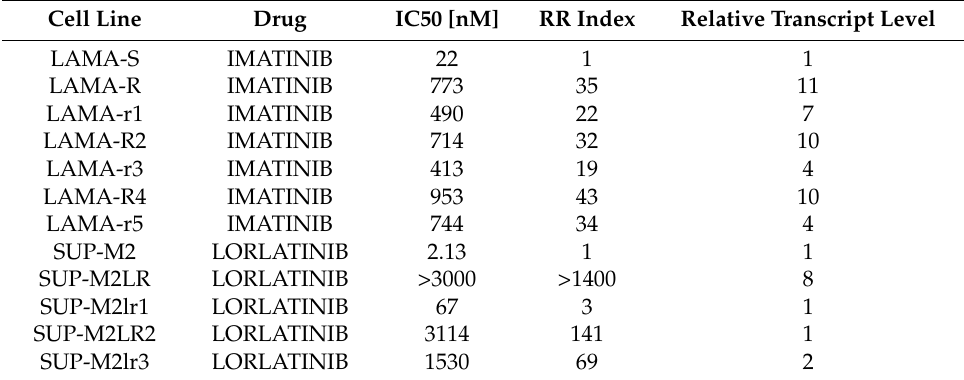
Table 1. IC50 values, Relative Resistance Index, and oncogene transcript level normalized on the parental cells (Relative Transcript Level) are shown in Table 1.